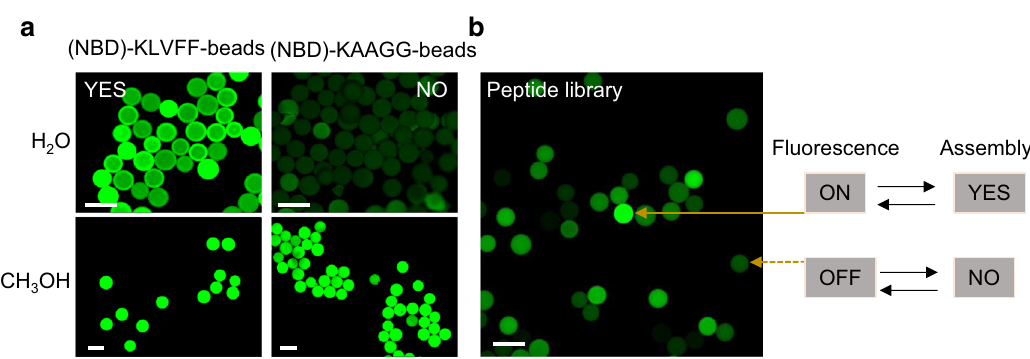
Fig. 2 Screening assay development and OBOC library screening for self-assembling peptides. a The fl uorescence microscope imaging of positive control (NBD)-KLVFF-beads and negative control (NBD)-KAAGG-beads in water and methanol after incubation for 20 min. The scale bar is 200 μ m. b Screening result of a representative region of a plate containing the OBOC library. The positive bead with an intense fl uorescent signal was detected (pointed with solid arrow), the bead with diminished fl uorescence was considered a negative bead (pointed with dotted arrow). The scale bar is 200 μ m. Table 1 Peptide information screened from OBOC